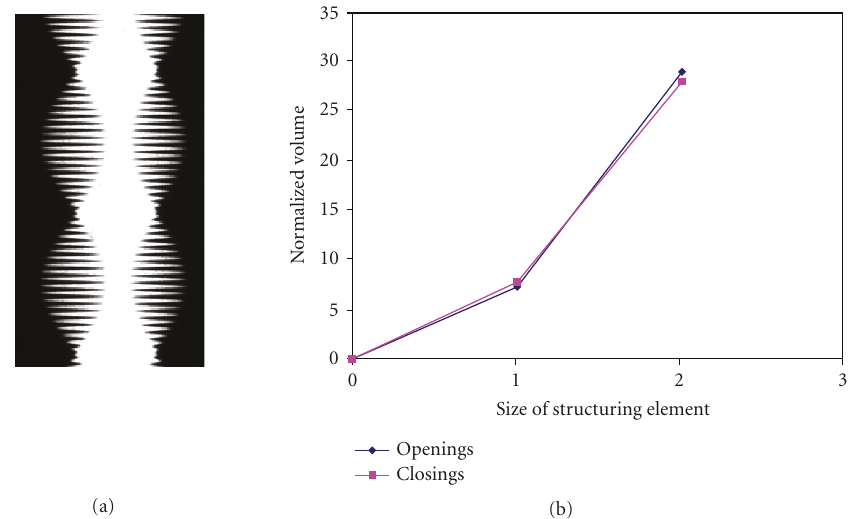
Figure 16: Succession of openings and closings with vertical structuring elements applied to a correctly exposed